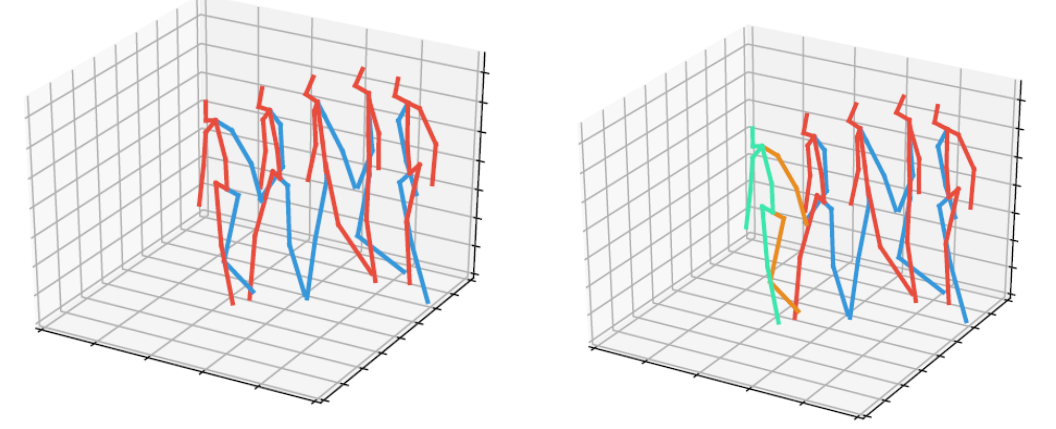
Figure 1. Skeleton visualization of a walking motion, and the anticipated frame of the full skeletonskeleton frame for 2s of input motion length and 0.4s of anticipation time. ( Left ) ground truth motion, i.e. the red-blue frames are recorded. ( Right ) initial motion segment and anticipated motion, the red-blue frames are from the recorded initial segment, the green-orange frame is the skeleton frame of the 17 markers anticipated by DMDd80.